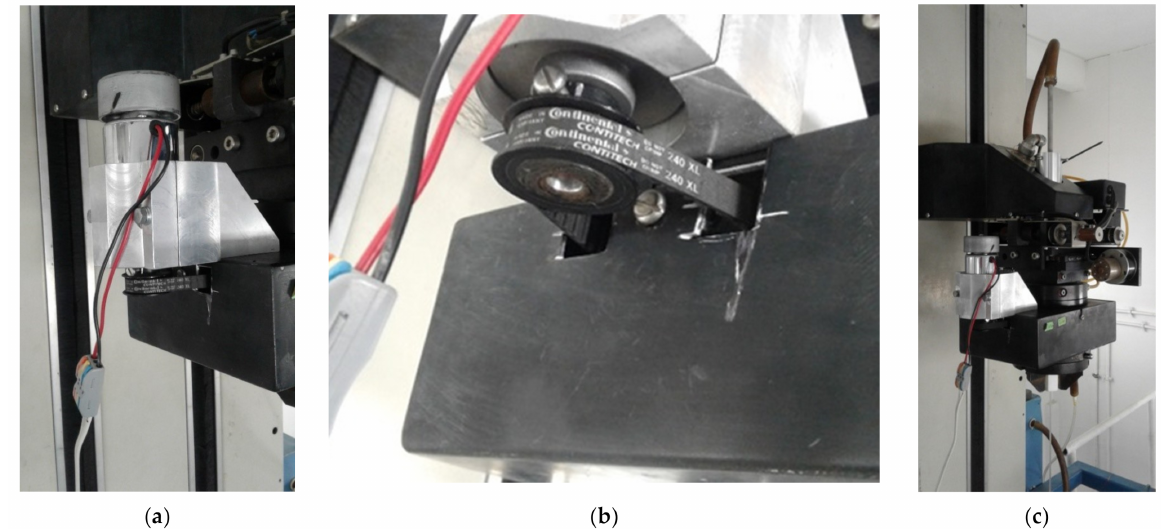
Figure 2. Installation of commutator motor: ( a ) lightweight aluminum carrier for the commutator motor; ( b ) drive belt and protective shroud; ( c ) general view of modified drawing tower feed unit with installed commutator motor.